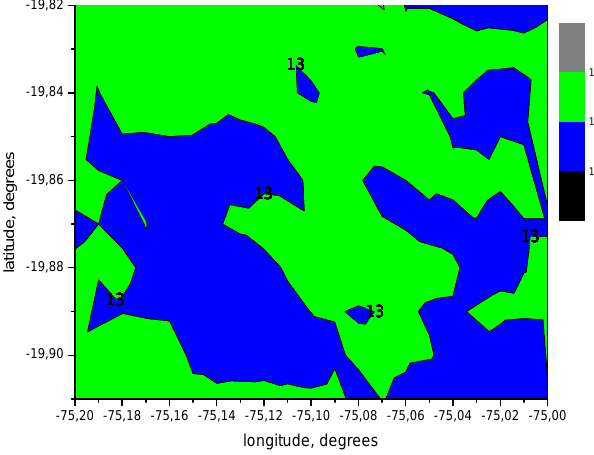
Fig. 10. The spatial distribution of a ef as derived using MODIS operational algorithm.